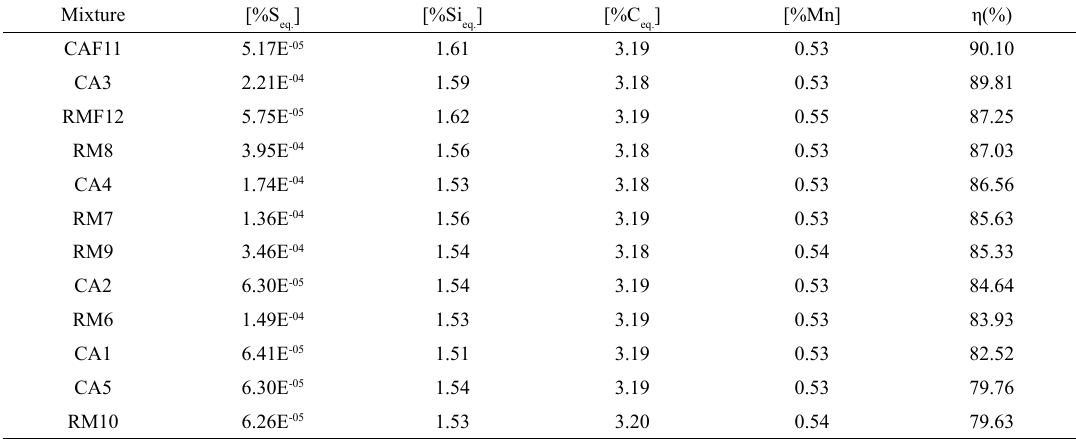
Table 4. Equilibrium (wt%) obtained for Thermo-Calc ® in cast iron and desulfurization yield (η(%)).